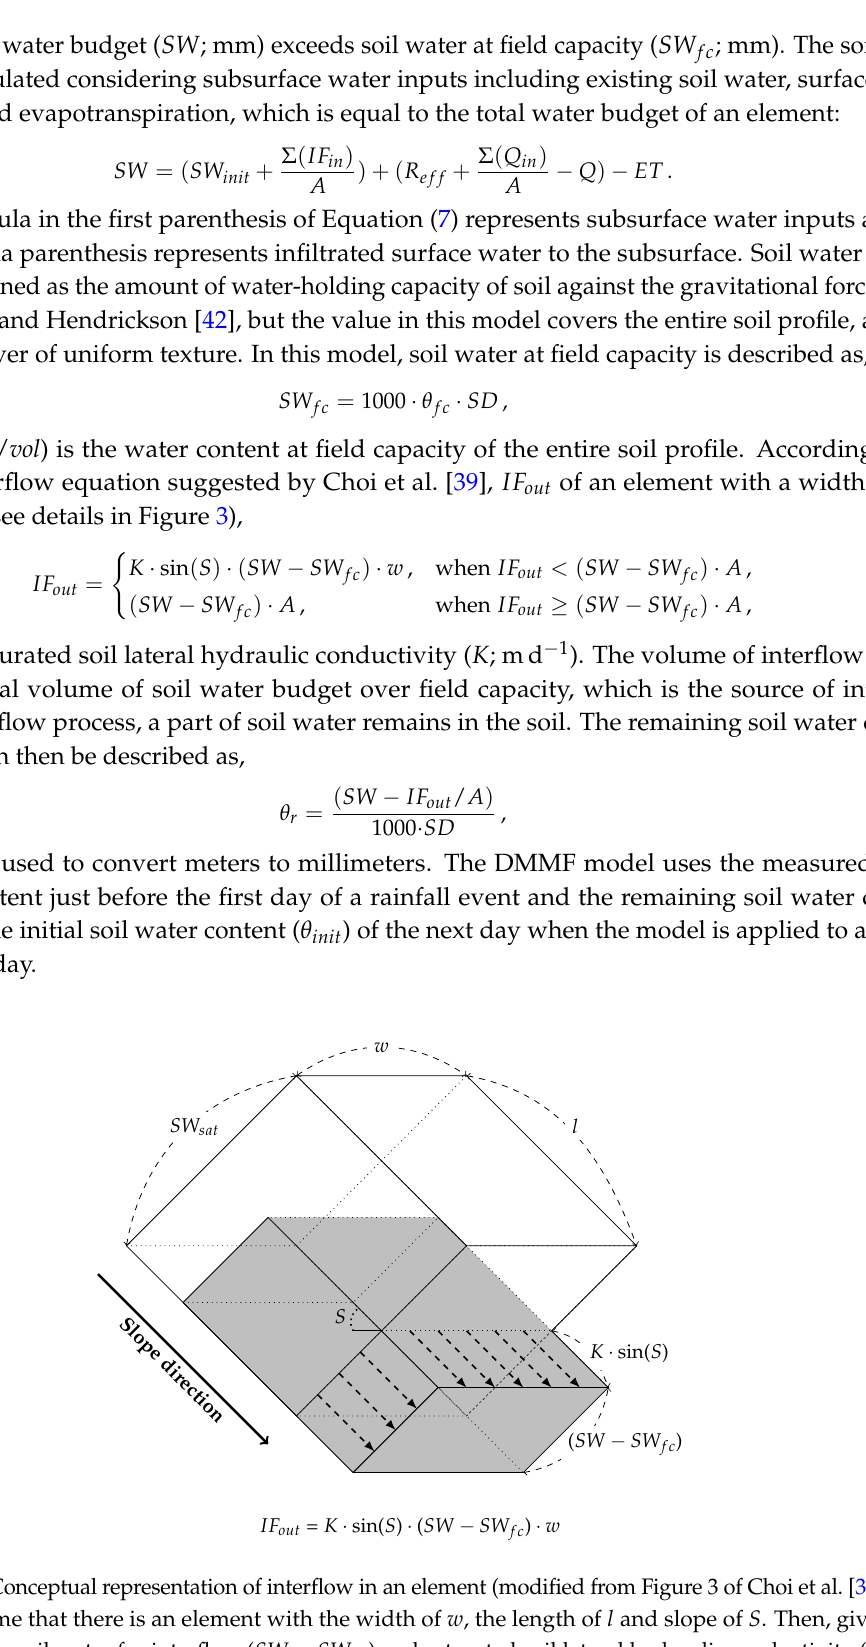
SW fc ) and saturated soil lateral hydraulic conductivity ( K ), −